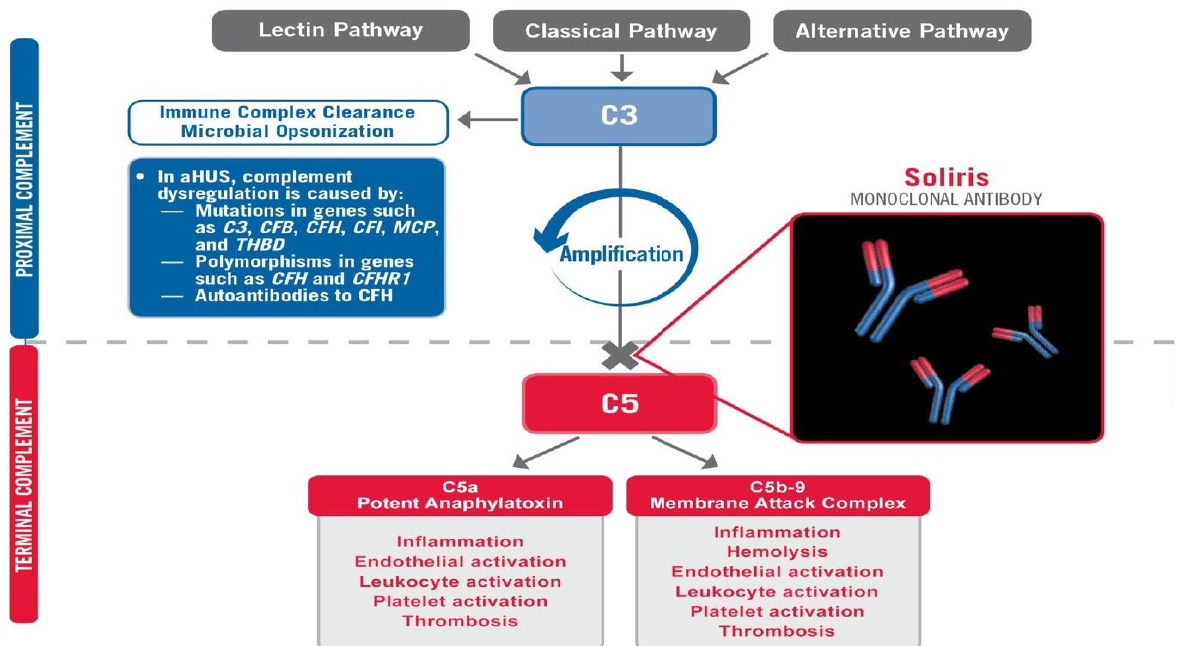
Figure 1. Eculizumab anti-C5 mechanism of action.